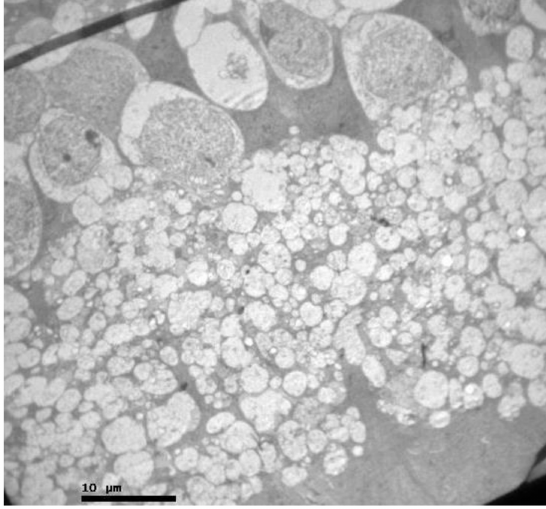
Figure 4. Group C. Nerve fiber and ganglion cell layer with no ultrastructural pathological alterations.